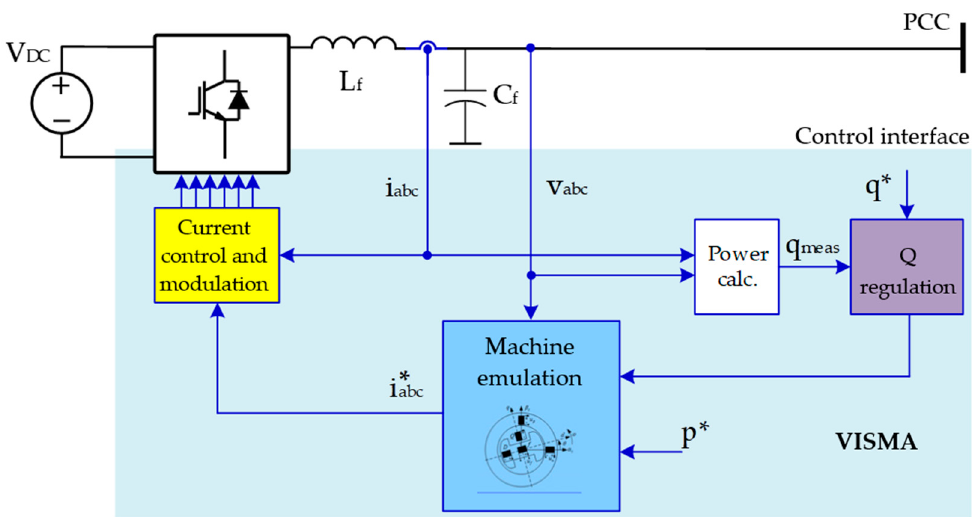
Figure 12. Grid-forming virtual synchronous machine control with current reference as output of synchronous generator model [37].